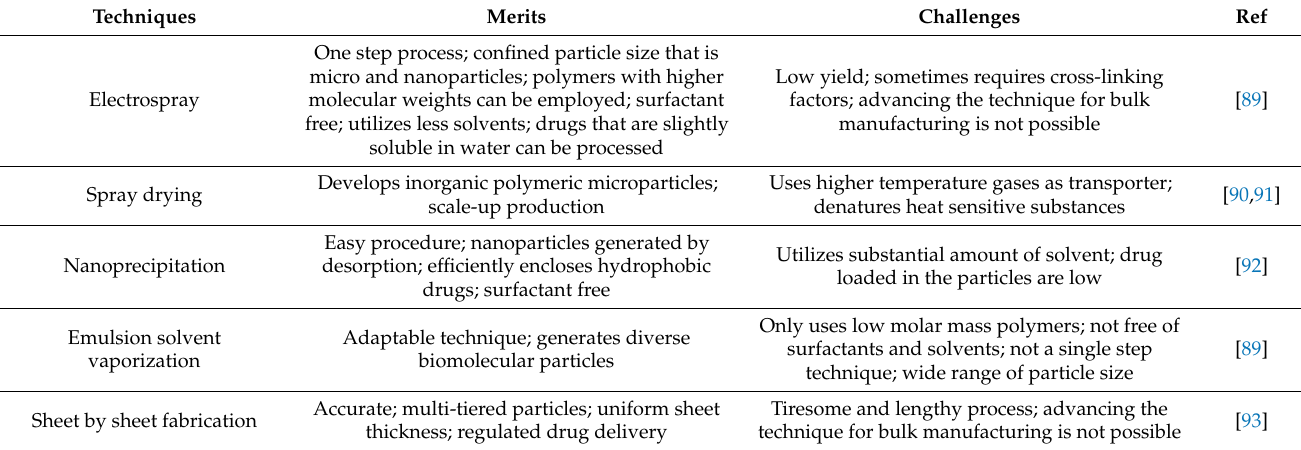
Table 4. Comparing electrospray to other common techniques.